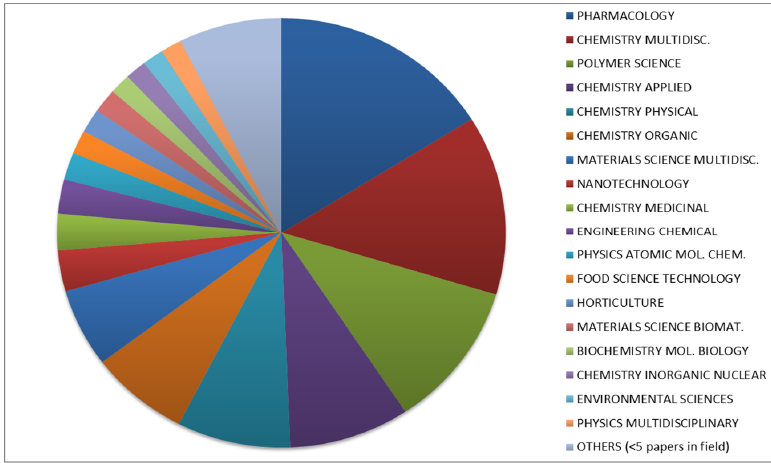
Figure 1. Number of papers on cyclodextrin-based nanosponges (CD NSs) published over the years from 1999 until 2019.